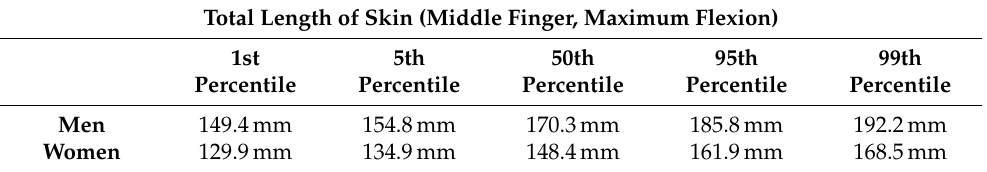
Table A4. Total length of skin over the middle finger at maximum flexion.